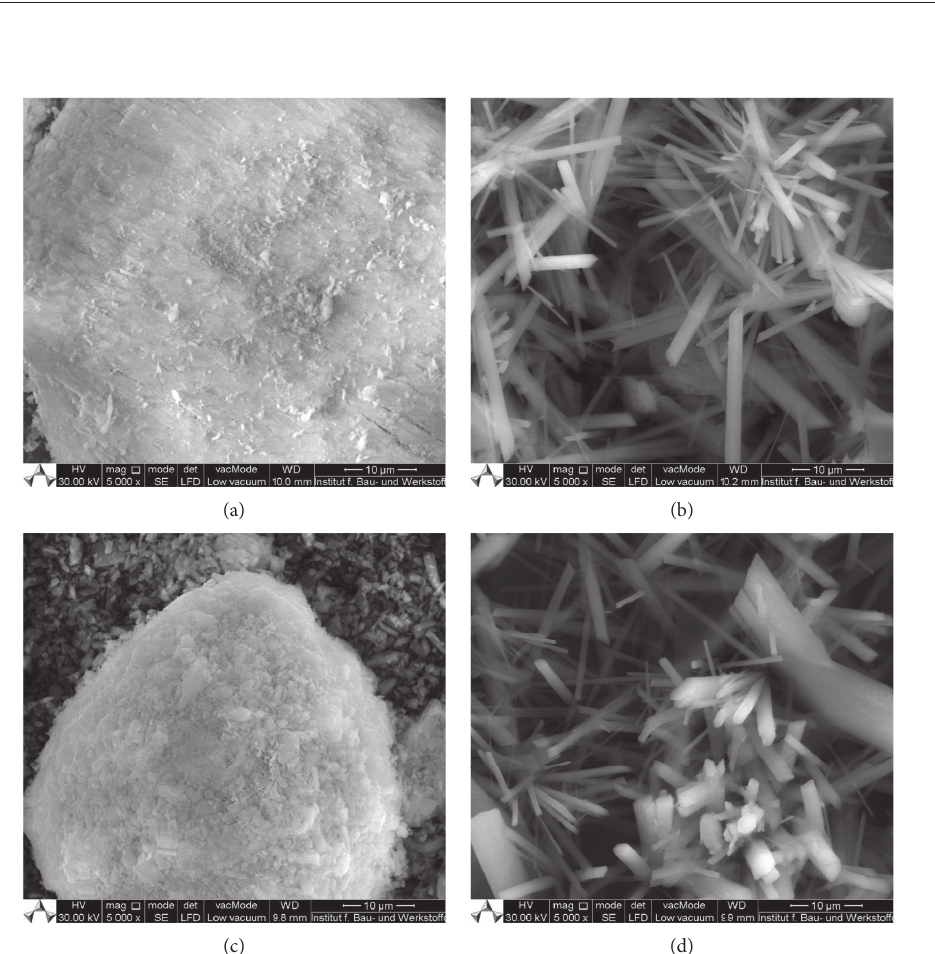
Figure 5: SEM images pure β -HH and β -HH after the first cycle before and after hydration: (a, b) pure β -HH before and after hydration, respectively, and (c, d) β -HH after the first cycle before and after hydration, respectively.